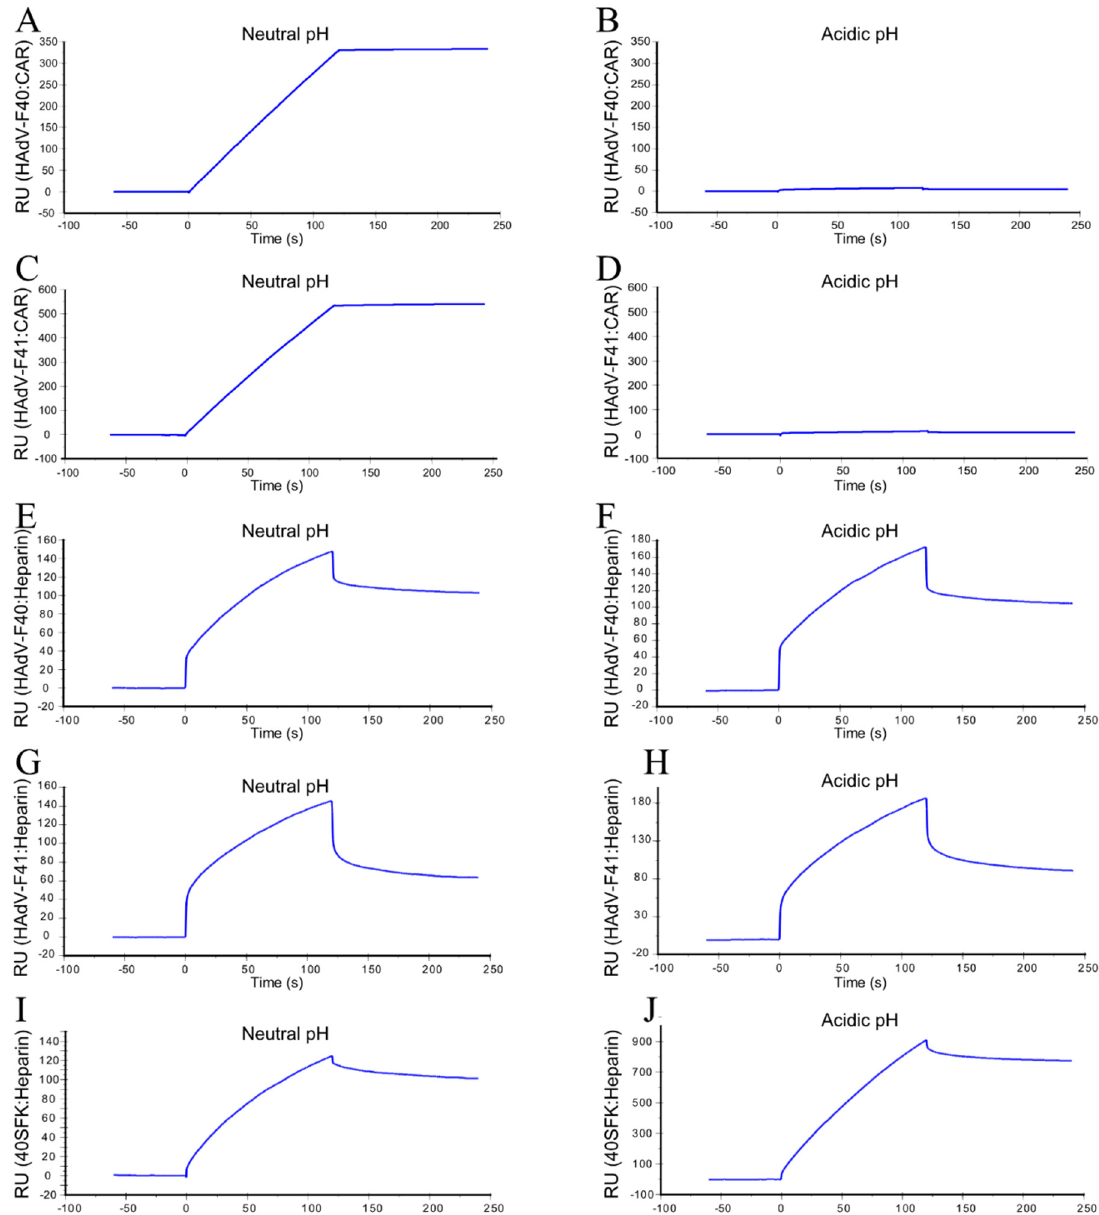
Figure 6. SPR analyses of HAdV-F40 and -F41 interactions with CAR and heparin and 40SFK interaction with heparin: ( A ) Untreated (neutral pH) HAdV-F40 or ( B ) acidic pH-treated HAdV-F40 or ( C ) untreated (neutral pH) HAdV-F41 or ( D ) acidic pH treated HAdV-F41 binding to immobilized CAR. ( E ) Untreated (neutral pH) HAdV-F40 or ( F ) acidic pH-treated HAdV-F40 or ( G ) untreated (neutral pH) HAdV-F41 or ( H ) acidic pH treated HAdV-F41 or ( I ) untreated (neutral pH) 40SFK or ( J ) acidic pH treated 40SFK binding to immobilized heparin. Interactions are displayed in response units (RU). All experiments were performed three times. Displayed is one representative set from each experiment.